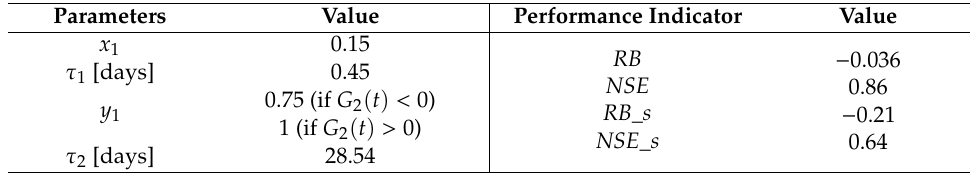
Table 3. Parameter values and performance indicators of the modified IHACRES model for the calibration period (e ff ective rainfall time-series generated from streamflow